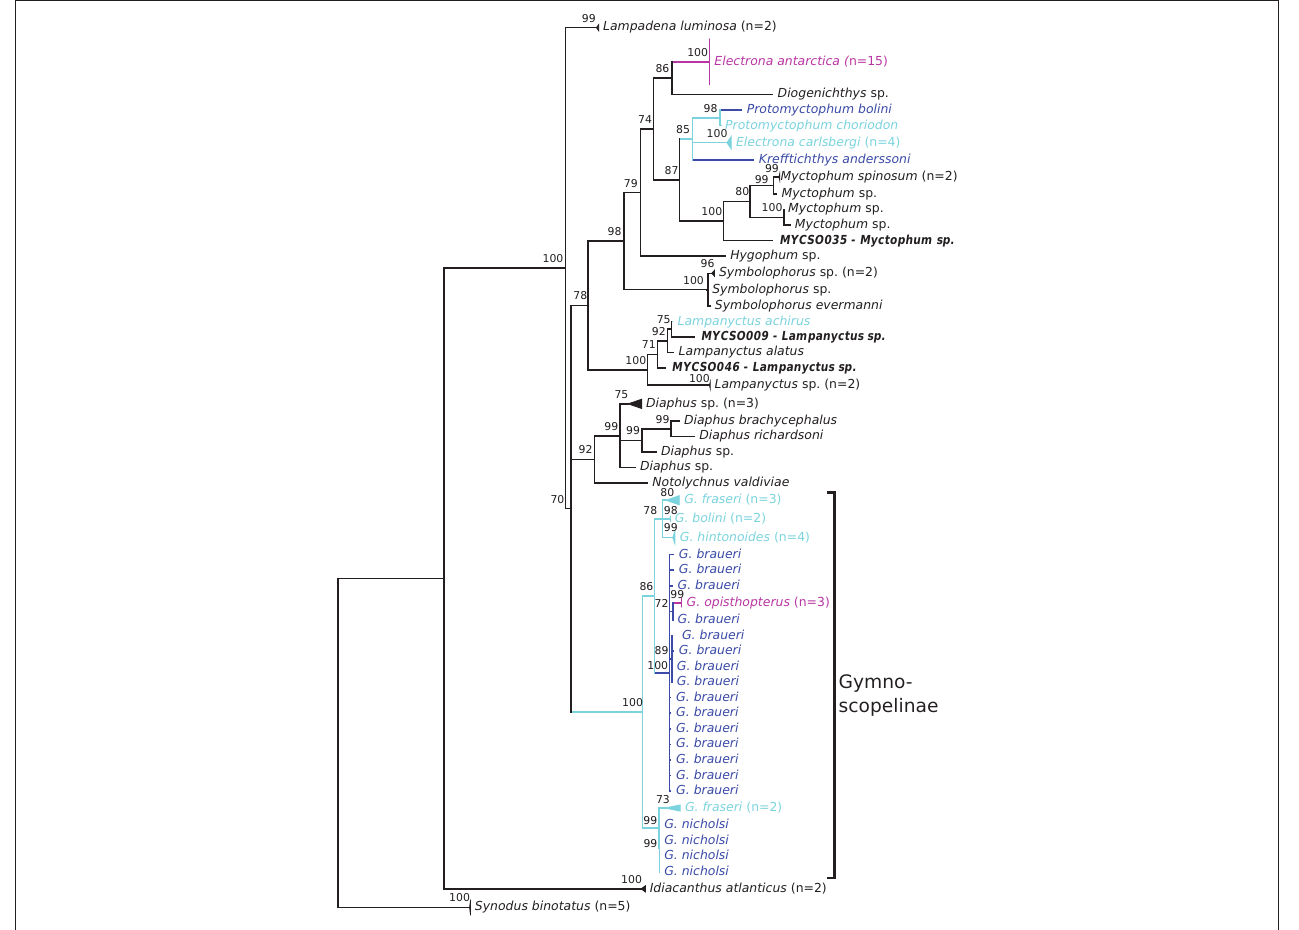
FIGURE 3 | Phylogenetic consensus tree of myctophid fishes based rhodopsin ( rh1 ) gene variation using a maximum likelihood analysis with 10,000 bootstrap permutations. Bootstrap support > 70 is shown above the branches; branches with lower support are collapsed to polytomies; species with Antarctic, broadly Antarctic, and sub-Antarctic distribution pattern following Duhamel et al. (2014) are depicted in purple, dark blue, and light blue, respectively (color figure available online). Number of collapsed samples noted in